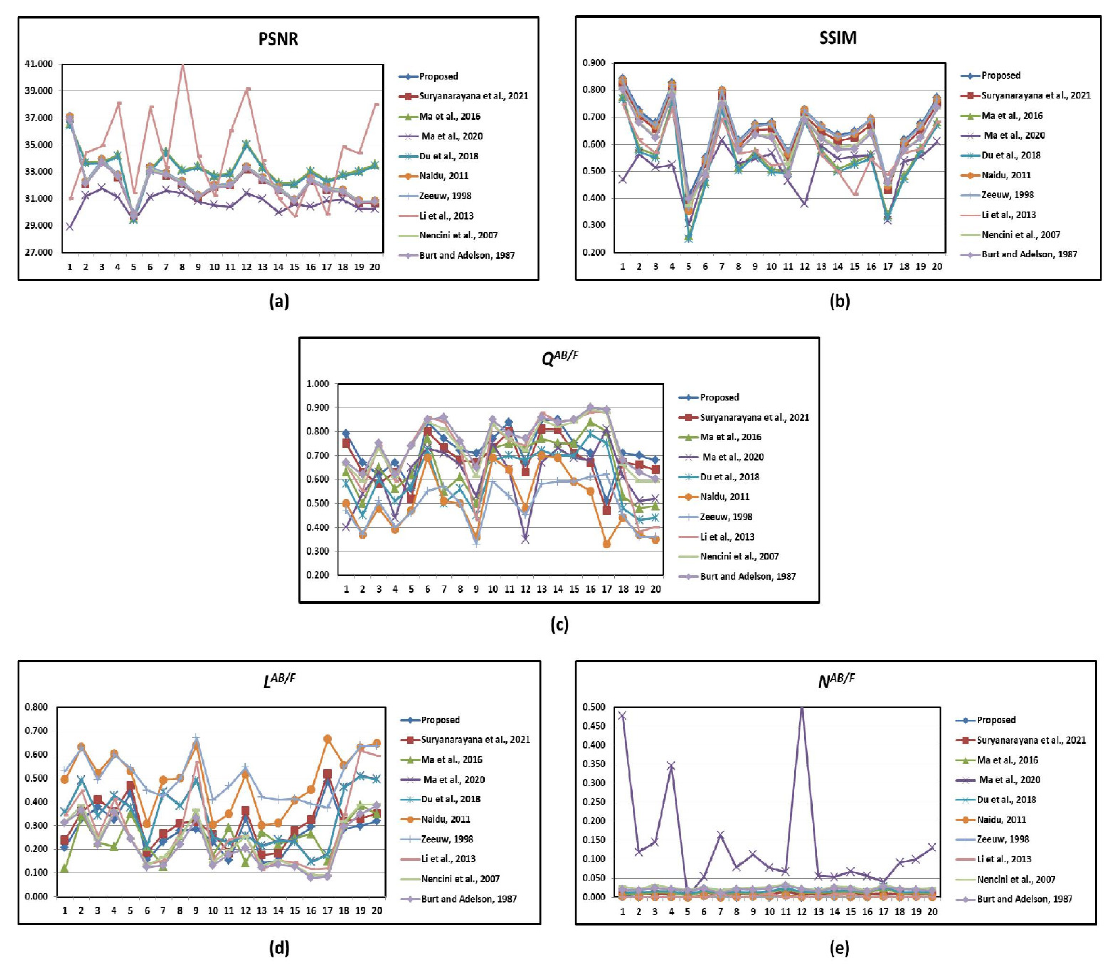
Figure 10. Metric results of different methods [17,20,22,33–38] on 20 IR-VIS test image pairs: ( a ) PSNR